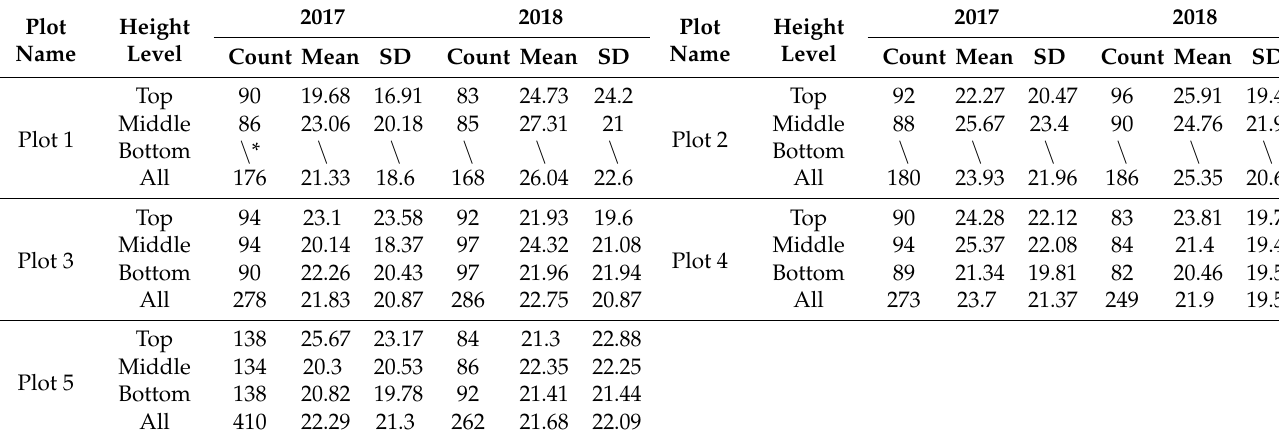
Table 3. Statistical characteristics (i.e., number of measurements (count), mean shoot inclination angle (mean), and standard deviation (SD)) of the shoot inclination angle distribution function (SIDF) measurements, which were derived using the manual estimation method in the five